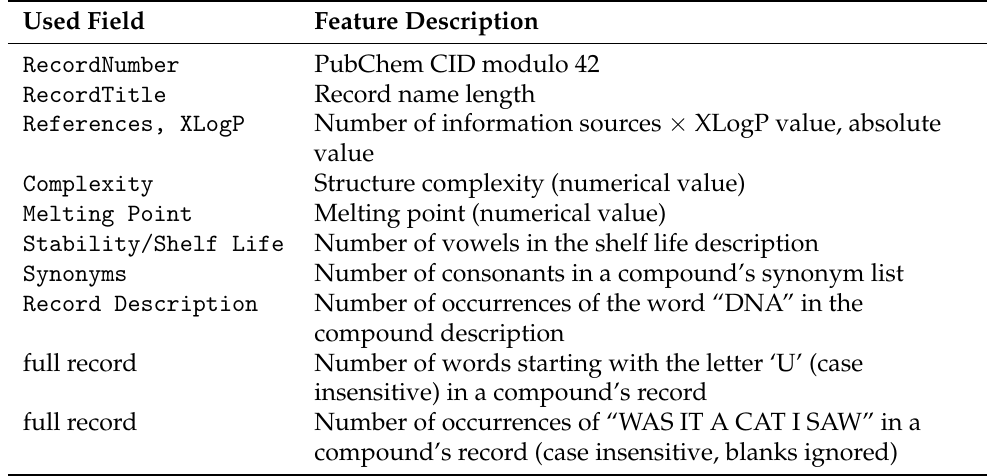
Table 1. Features used by M AD H ATTER . Features are read from the JSON file of a PubChem entry using the field “ name ”. In addition to the information from PubChem, M AD H ATTER uses the CSI:FingerID score as a